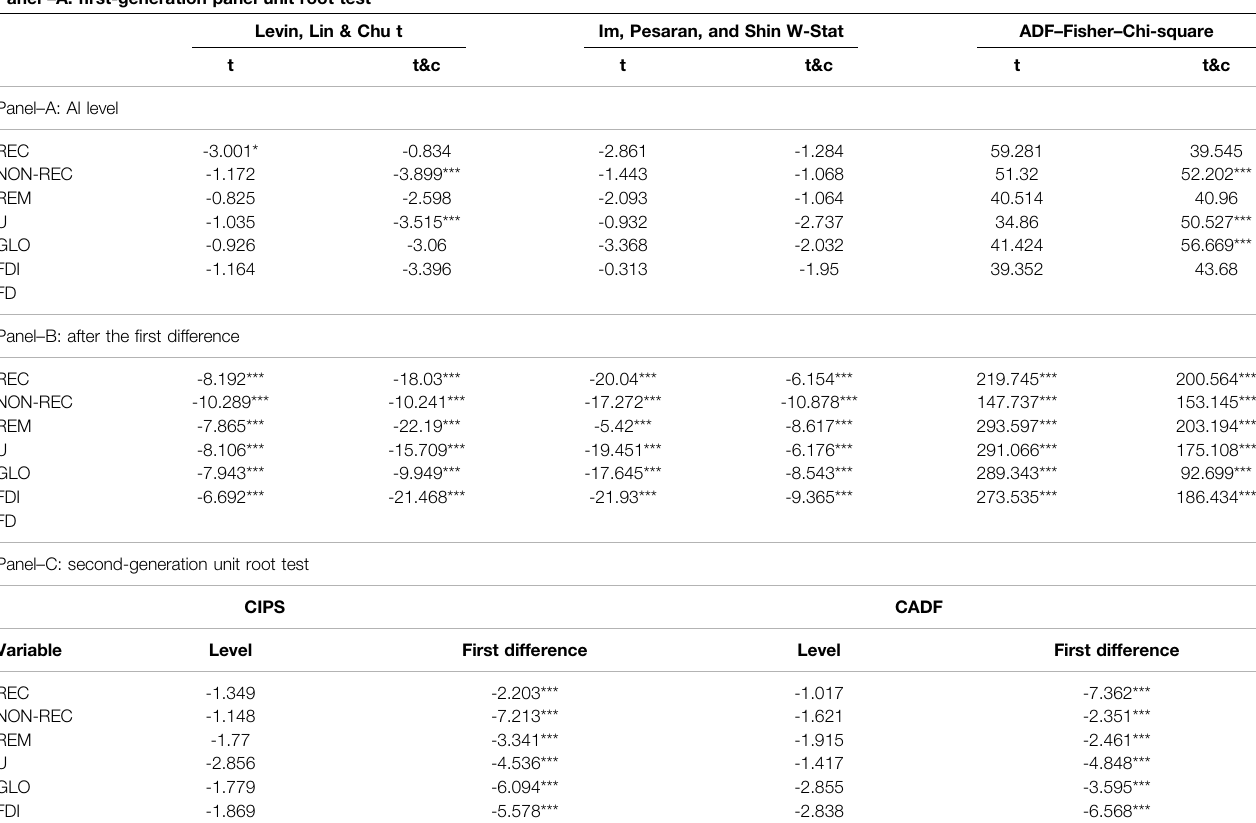
TABLE 3 | Results of the panel unit root test. Panel – A: fi rst-generation panel unit root